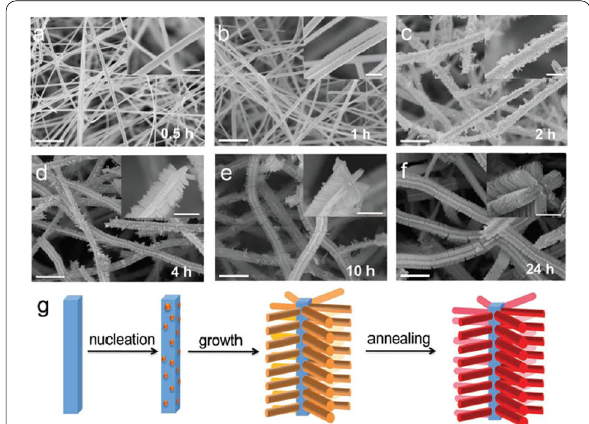
Fig. 5 a – f SEM images of the products (after annealing) at various reaction stages by setting the reaction time. The insets are the corresponding magnified SEM images. The scale bars in the figures and insets are 2 μm and 500 nm, respectively. g Schematic of the formation process of the hierarchically assembled α-Fe 2 O 3 /SnO 2 nanocomposite. Reprinted with Permission from [74]. Copyright, Wiley-VCH